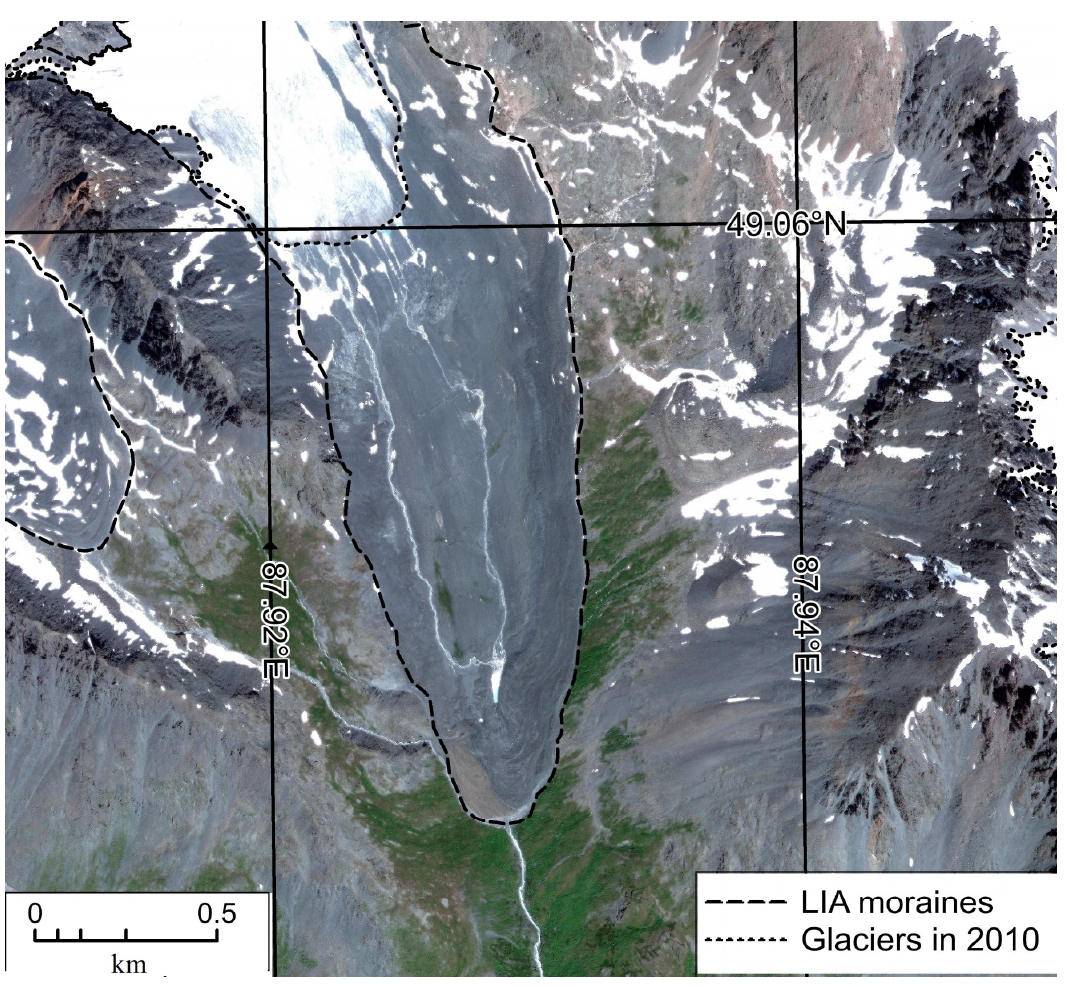
Figure 2. Delineation of the Little Ice Age (LIA) moraine, Postigiyn‑Gol basin, using a Geoeye‑1 image.